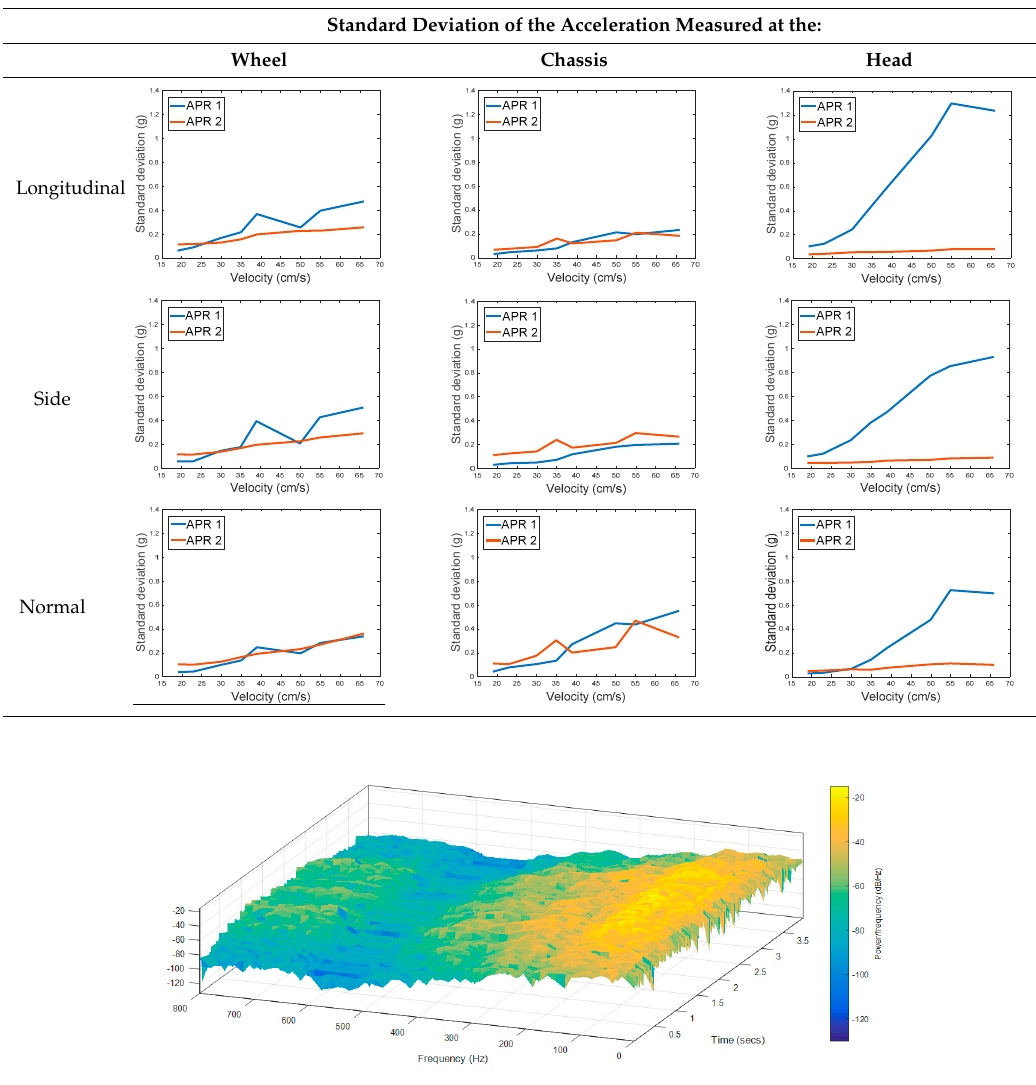
Figure 13. Frequency spectra of the accelerations measured over the longitudinal axis at the head of the APR-2 prototype (with passive suspension).